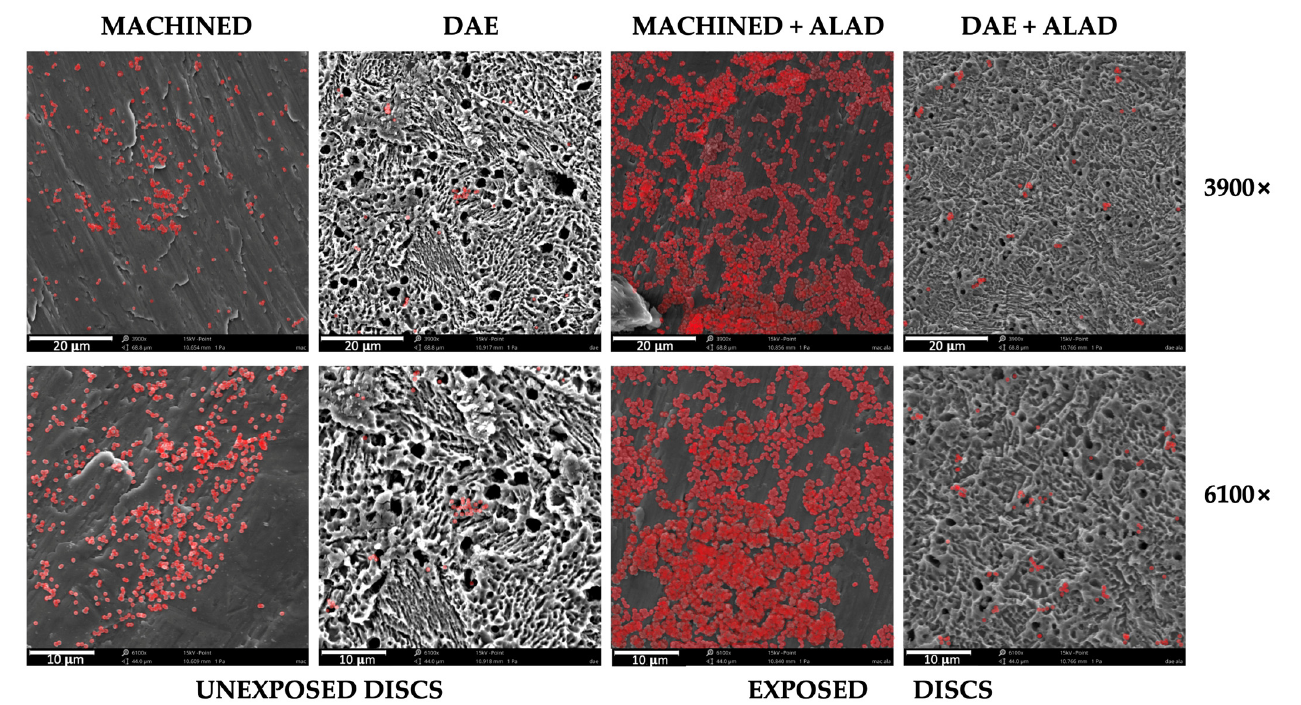
Figure 3. Scanning electron microscope observations at different magnifications, 3900× and 6100×, of Streptococcus oralis biofilm grown for 24 h + 24 h on MACHINED and DAE discs unexposed and exposed to ALAD gel and red LED. Bacteria are colored in red; lighter colors correspond to higher bacterial density.